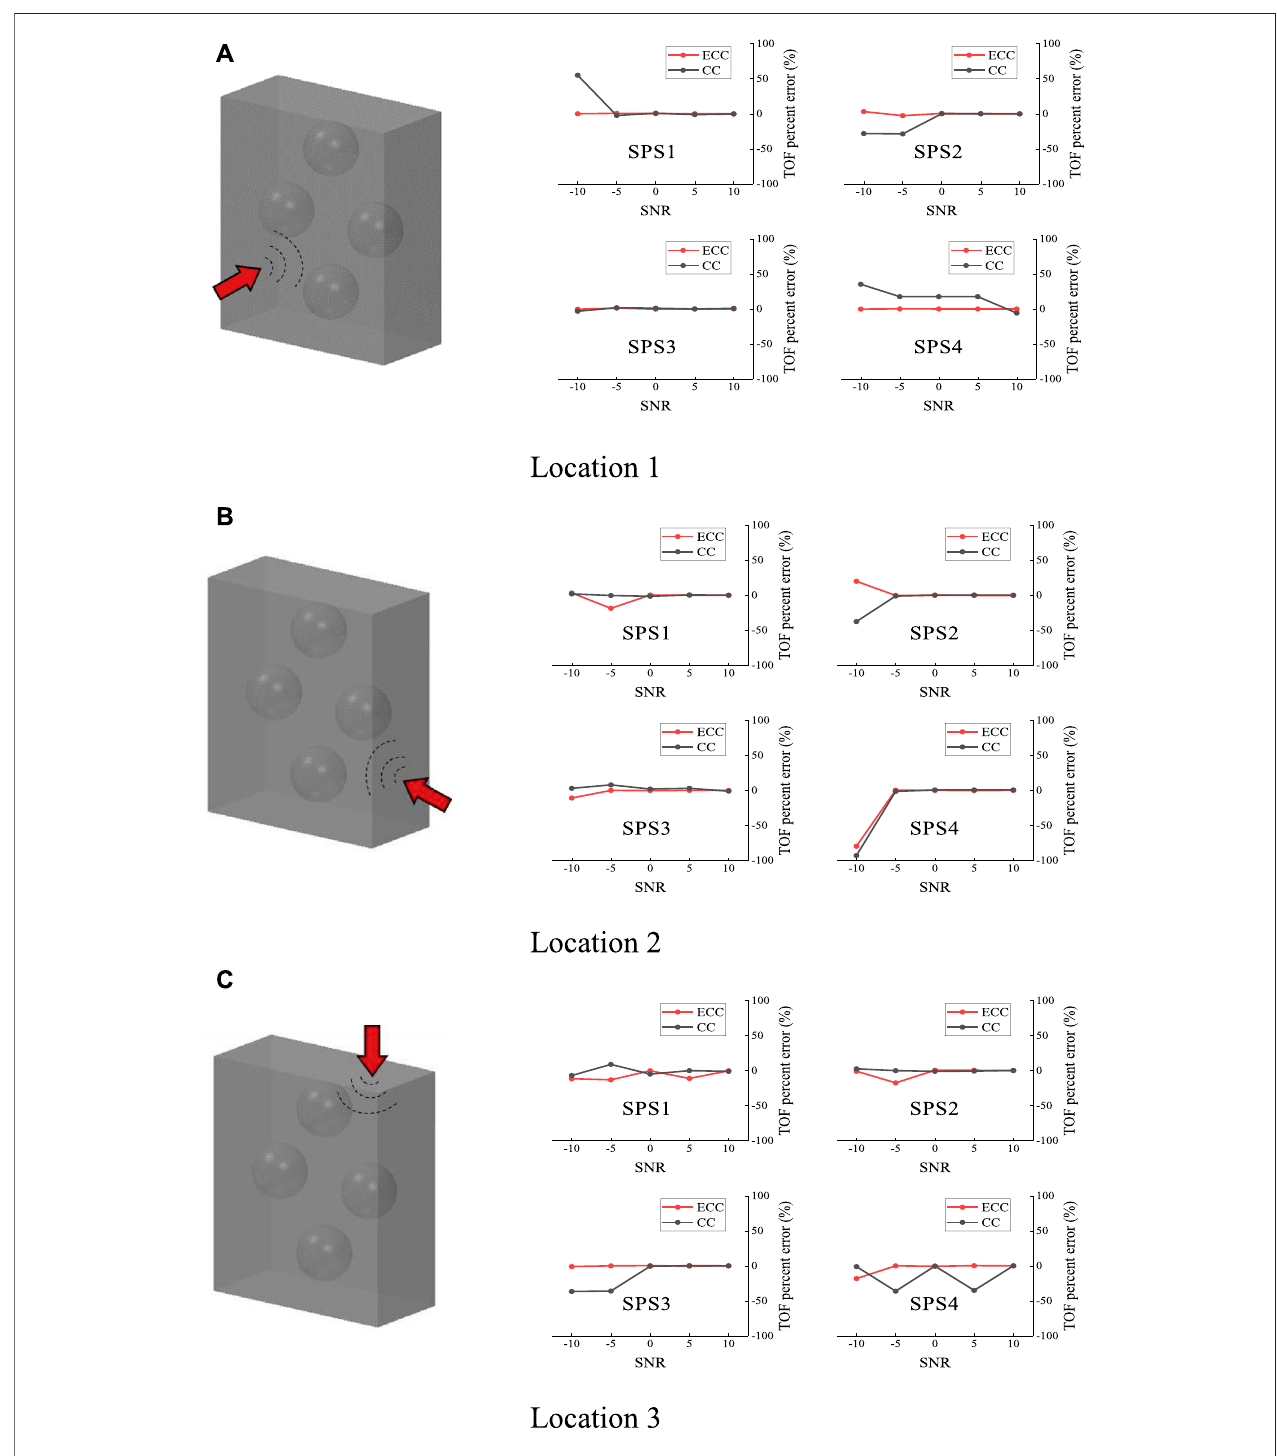
FIGURE 8 | TOF percent errors using ECC and CC algorithms. (A) Location 1. (B) Location 2. (C) Location 3.